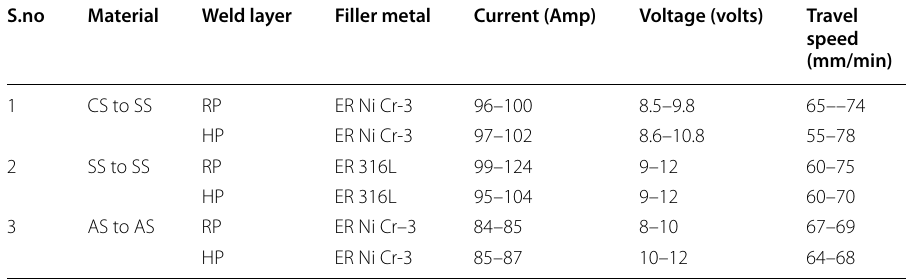
Table 5 Minimum and maximum values of process